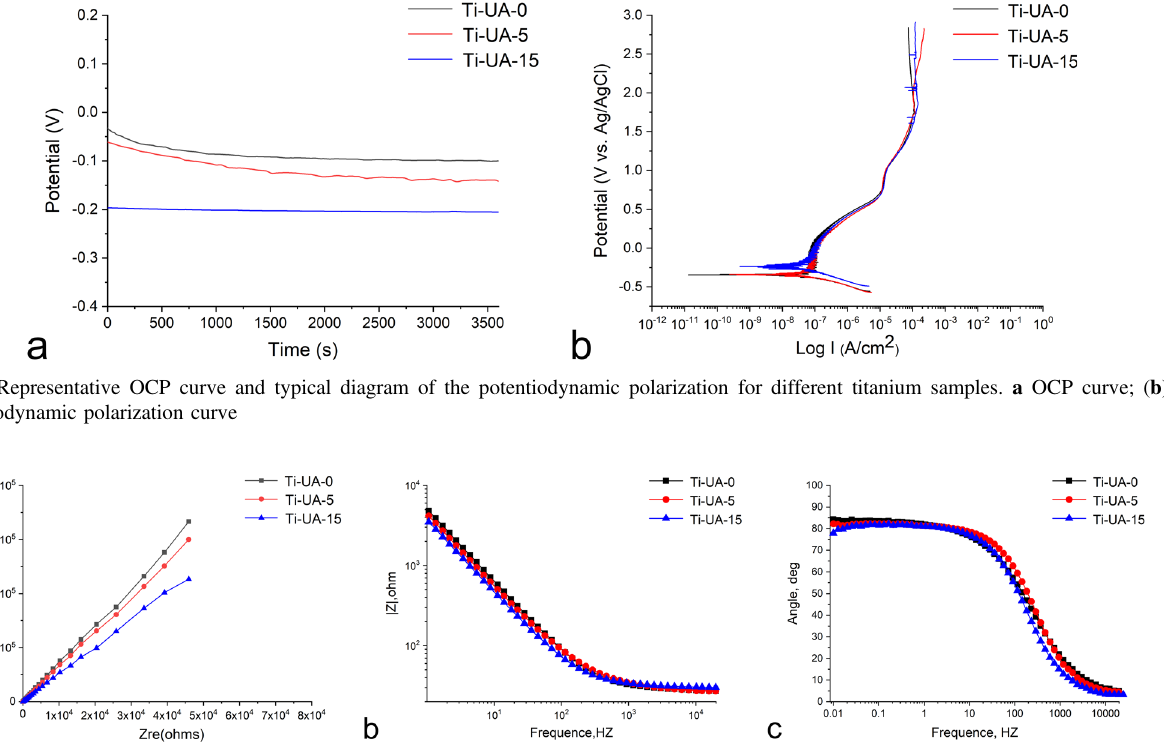
Fig. 5 Electrochemical impedance spectroscopy of pure titanium specimens in HBSS with different uric acid concentrations. a Nyquist plot diagram for different titanium samples; ( b ) Bode |Z | diagrams for different titanium samples; ( c ) Bode phase angle diagrams for different titanium samples